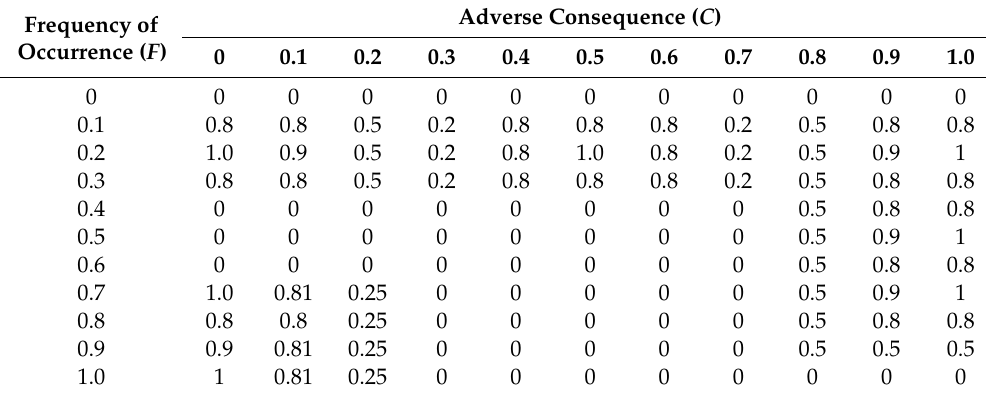
Table 5. Fuzzy union matrix ( U ) of all relations of the